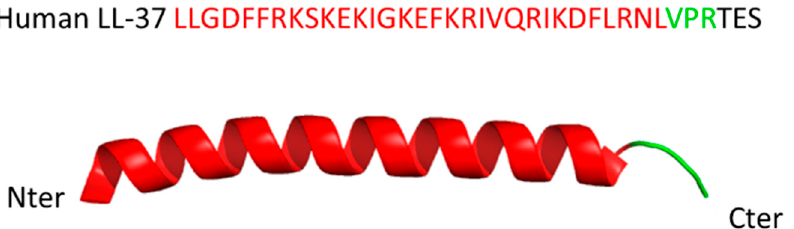
Figure 2. Sequence and ribbon representation structure of human LL-37 (high-quality structure as determined by 3D nuclear magnetic resonance spectroscopy).